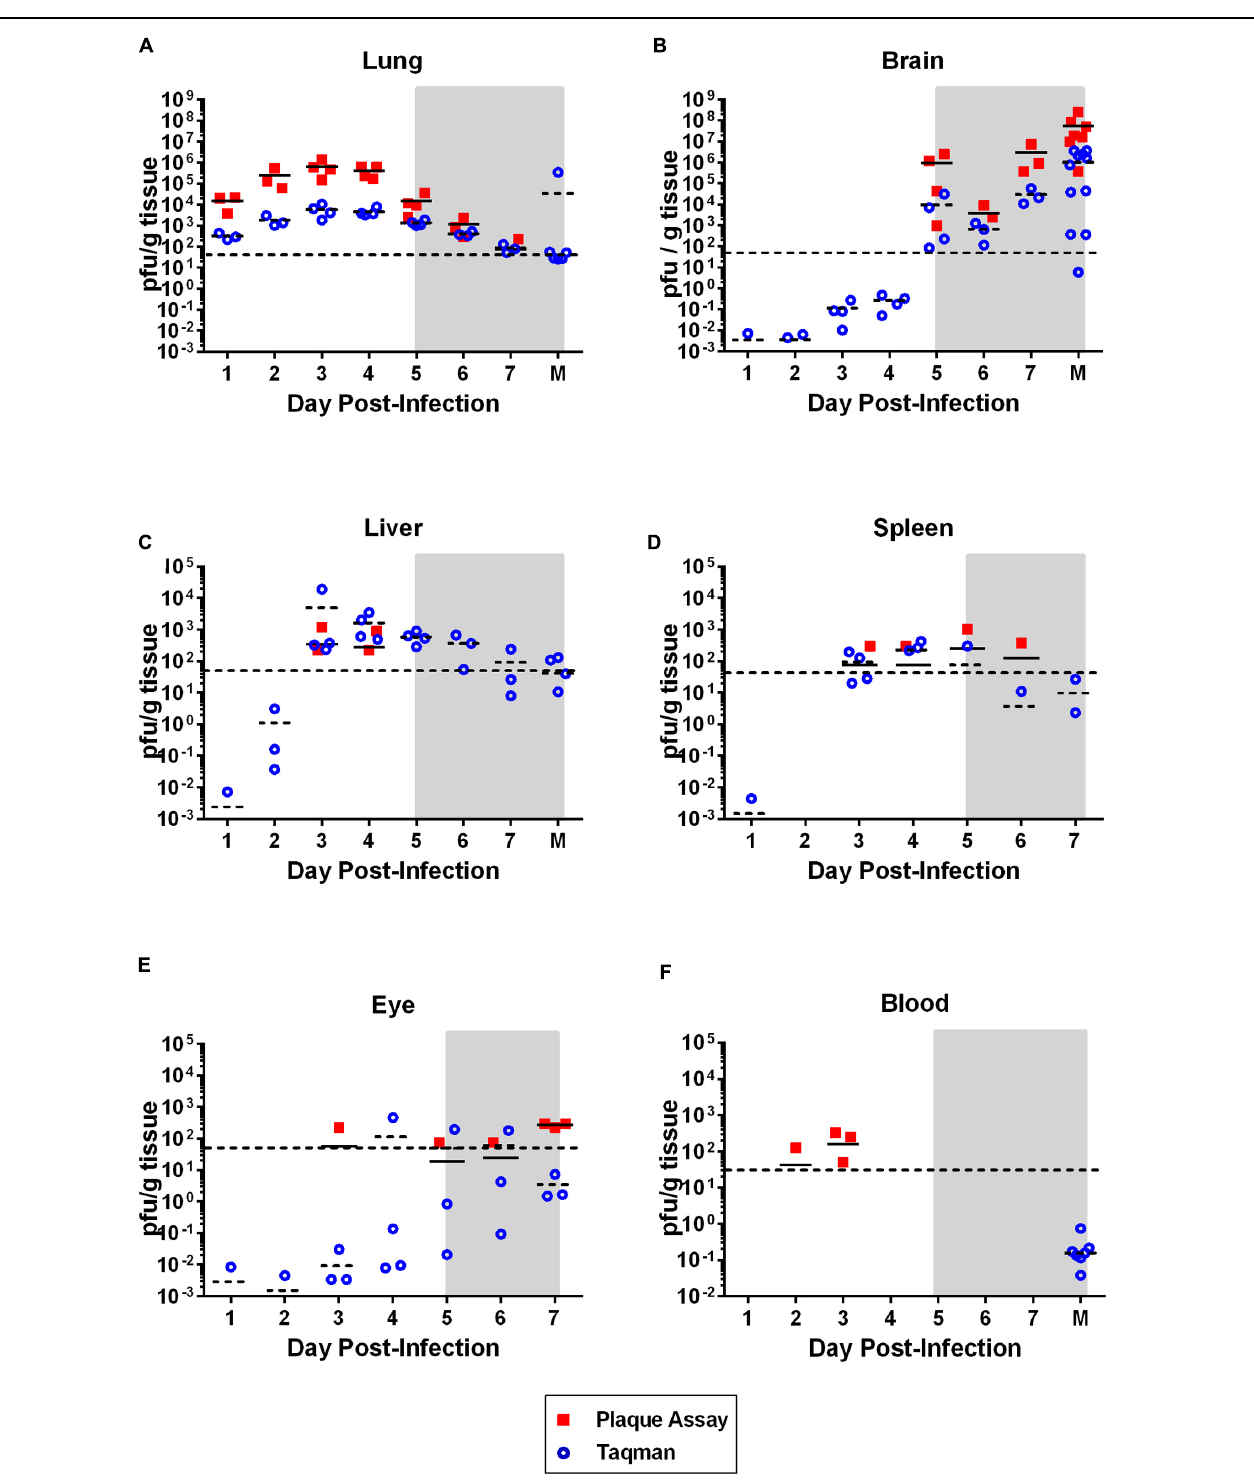
FIGURE 2 | Virus dissemination over time. Virus was measured in the indicated tissue by plaque assay (solid squares; pfu/g tissue) or taqman RT-PCR (open circles; pfu equivalents/g tissue). Horizontal line on each graph represents the limit of detection of the plaque assay (50 pfu). The gray shaded box on all graphs represents the window of clinical disease (5–7 dpi). For (A–C,F) , the M on the x -axis stands for ‘moribund’ and represents historical samples from previous Lewis rat experiments (correspond to 7–8 dpi). Tissue samples were taken at the time the rat was moribund and are included here for comparison purposes. These samples are not available for (D) and (E)